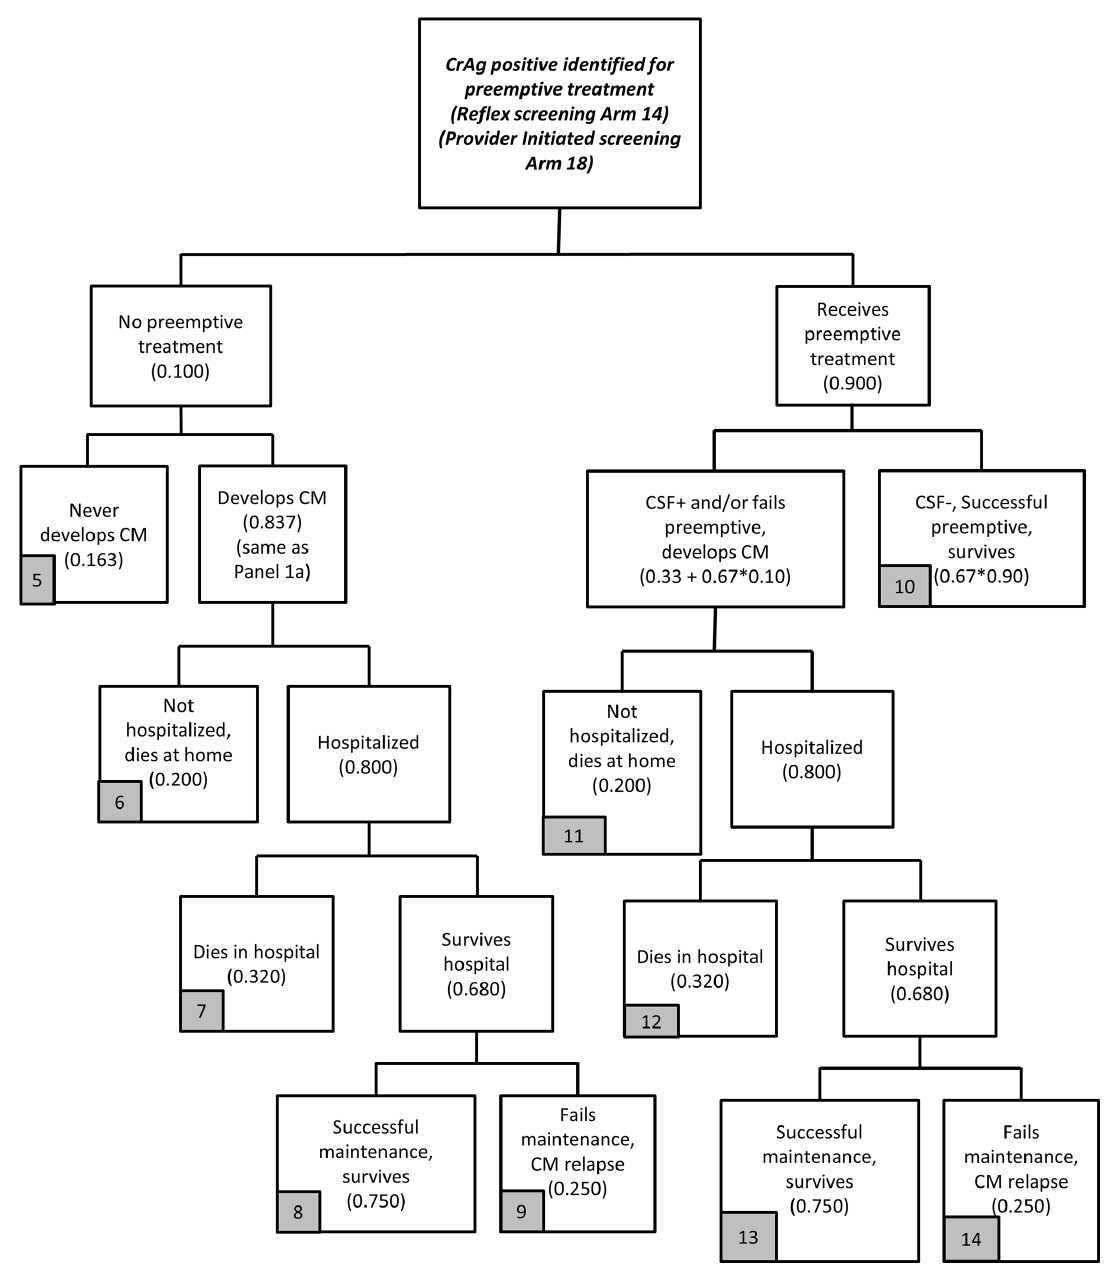
Fig 9. Treatment model flowchart (Panel